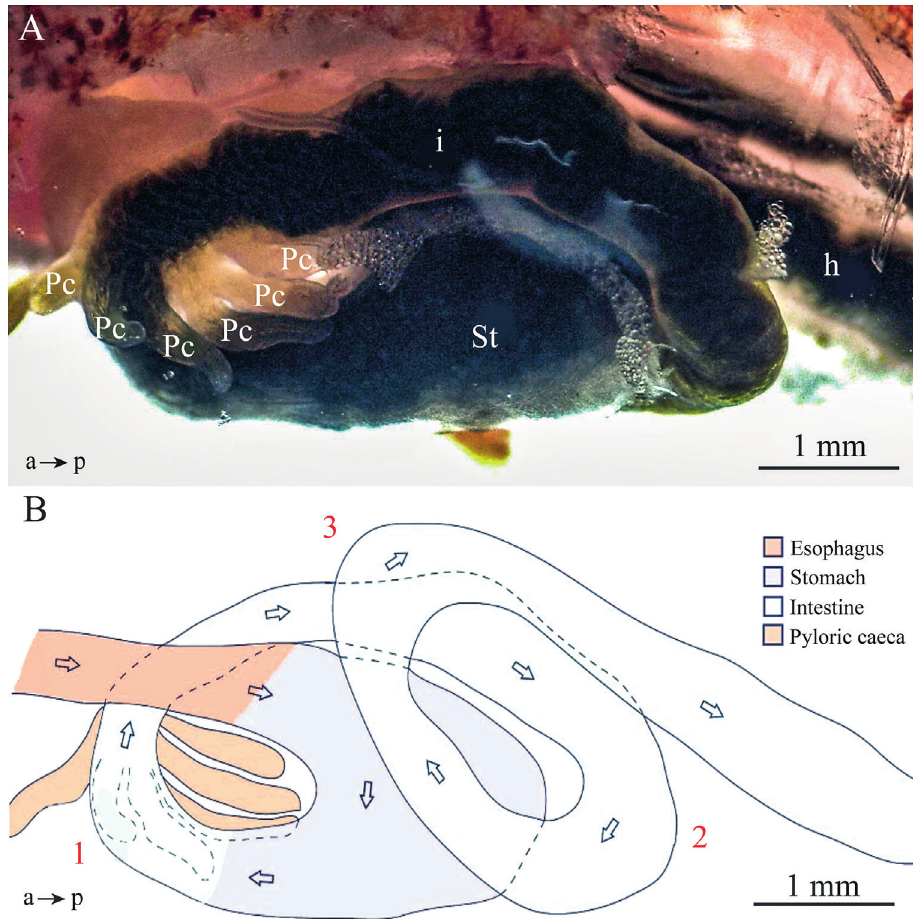
FIGURE 1 | Paracheirodon axelrodi, anatomical arrangement of the digestive tract. A. Left lateral view of the digestive tract under stereoscope showing pyloric caeca (Pc), stomach (St), intestine (i), hindgut (h). B. Schematic representation of the left lateral view of the digestive tract showing the curvatures of the intestine. The most anterior portion of the intestine presents the first dorso-lateral curve (1), from which the six pyloric caeca are observed. At the second curve (2), the intestine was followed by a posterior extension that lay over the stomach. From this point posteriorly, it developed in an antero- dorsal direction, on the left side of the stomach. The intestine is followed by a third curve (3) in a postero- ventral direction. a → p, antero-posterior